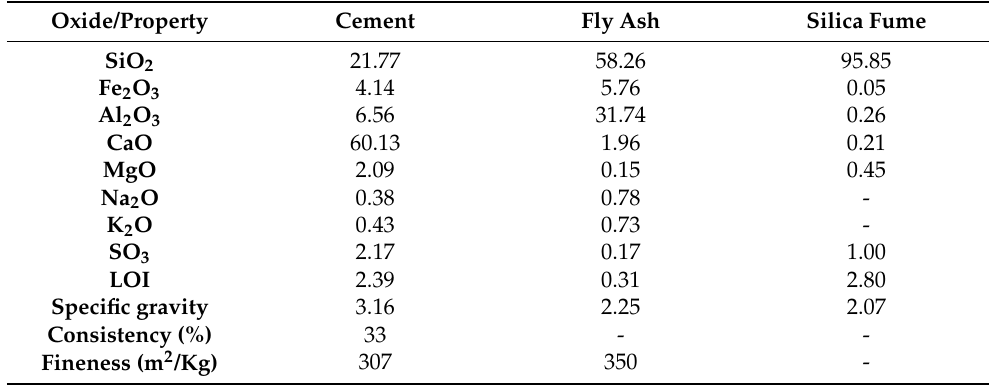
Table 1. Binder materials